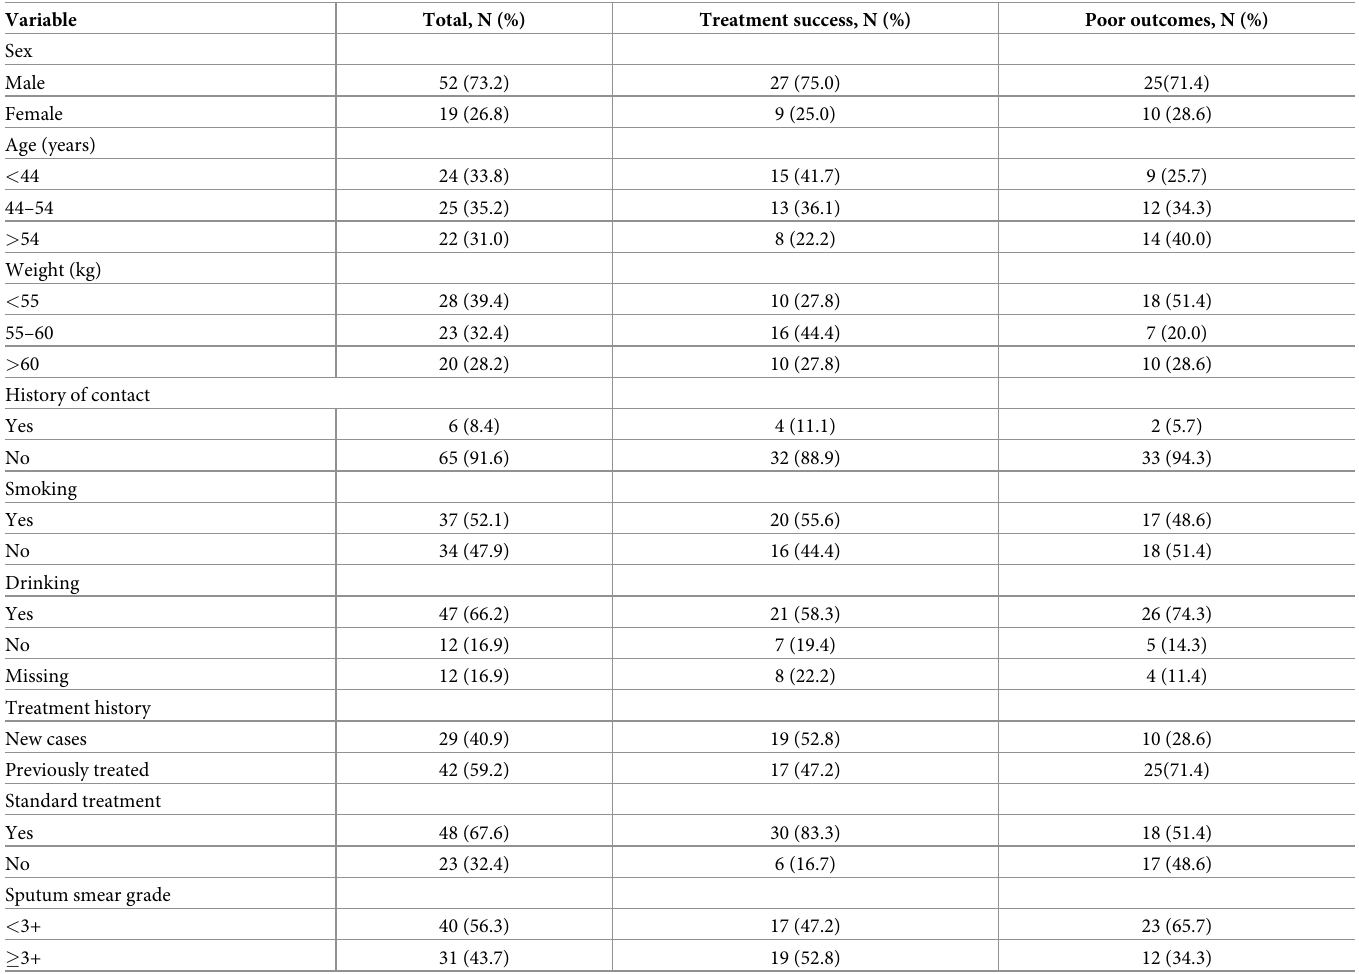
Table 1. Demographic characteristics of 71 multidrug-resistant tuberculosis